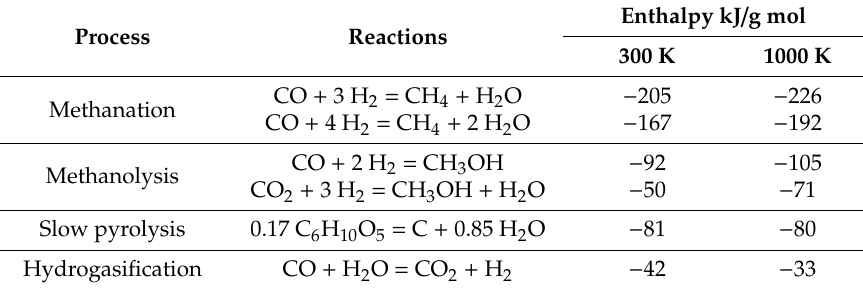
Table 2. Exothermic cellulose pyrolysis reactions and their enthalpy values [17,67].